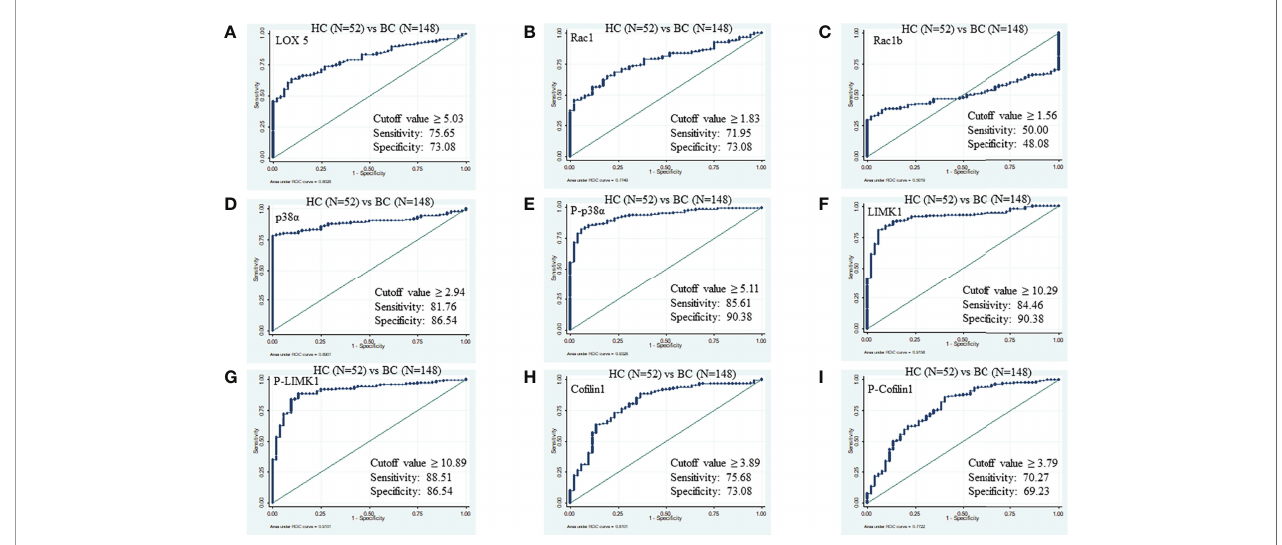
FIGURE 2 | ROC of serum proteins between HC and BC. (A) LOX5; AUC: 0.802, (B) Rac1; AUC: 0.774, (C) Rac1b; AUC: 0.501, (D) p38 a ; AUC: 0.890, (E) phospho-p38 a (Y-182); AUC: 0.932, (F) LIMK1, AUC: 0.915 (G) phospho-LIMK1 (T-508); AUC: 0.910, (H) Co fi lin1; AUC: 0.810, (I) phospho-Co fi lin1 (S-3); AUC: